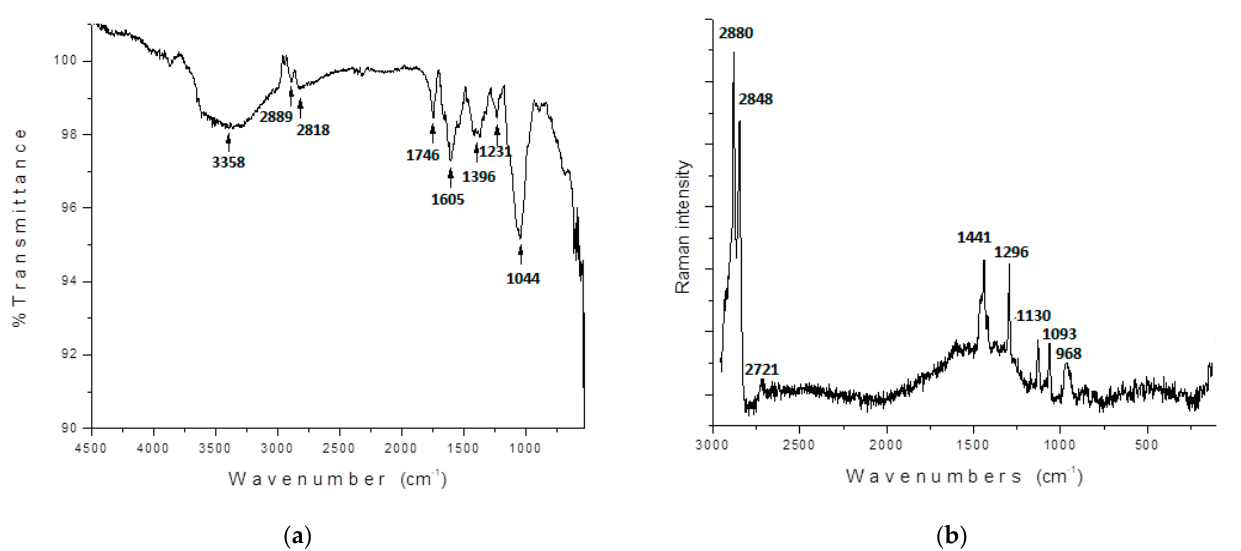
Figure 4. FTIR ( a ) and Raman ( b ) spectra of powdered mucilage extracted from OFI fruit peels.